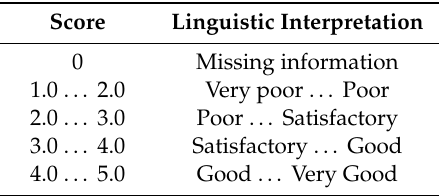
Table 2. Grading scale and qualitative